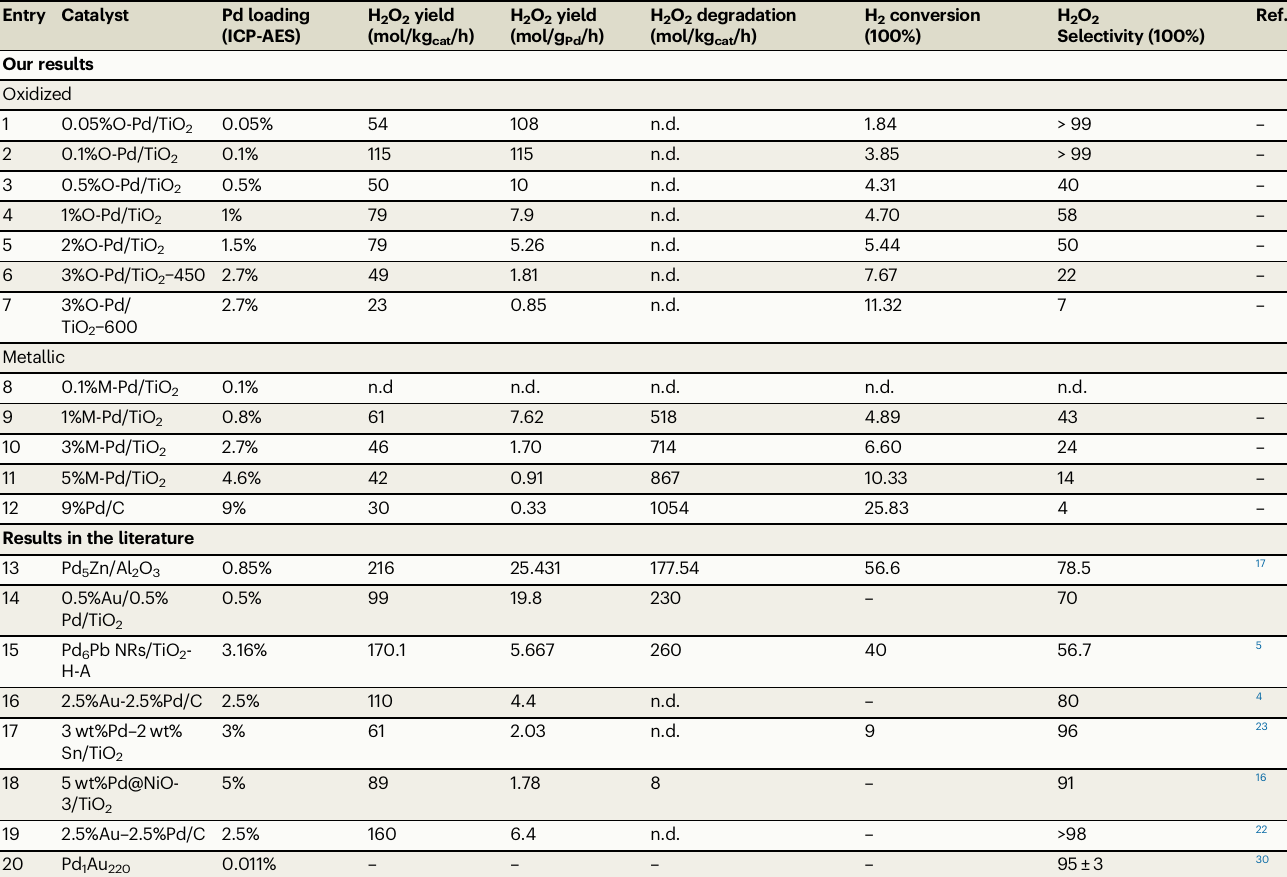
Table 1 | Comparison of performance of the representative catalysts with our catalysts a